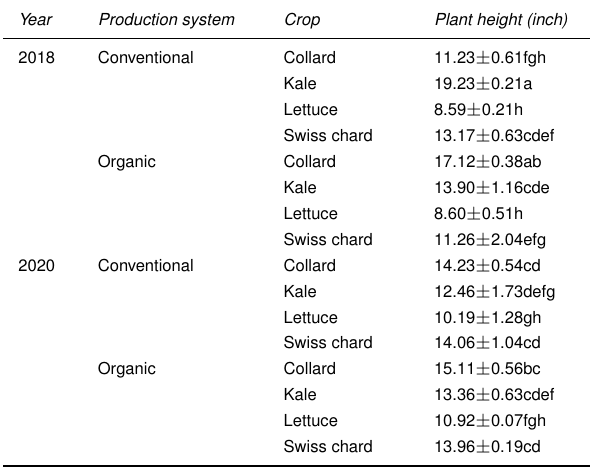
Table 2. Mean ( ± standard error) plant height of leafy greens (collard, kale, lettuce, swiss chard) grown in the year (2018 and 2020) in two production systems (organic and conventional).